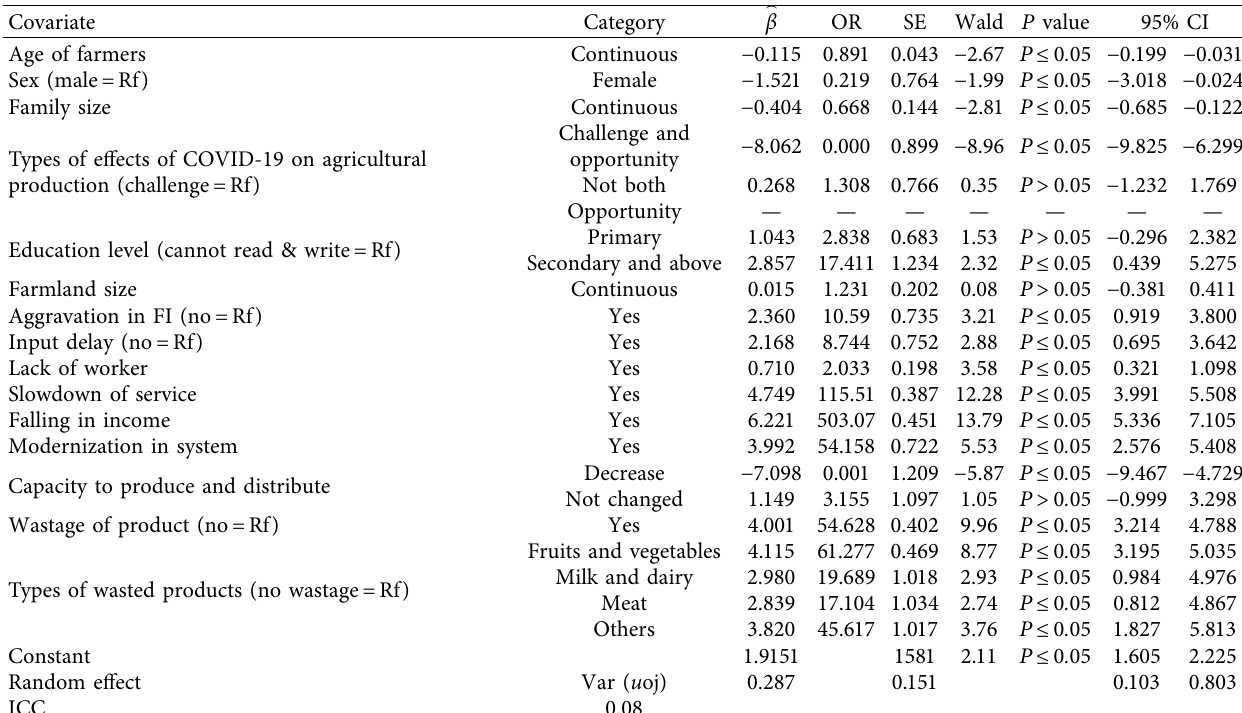
Table 6: Random intercept model